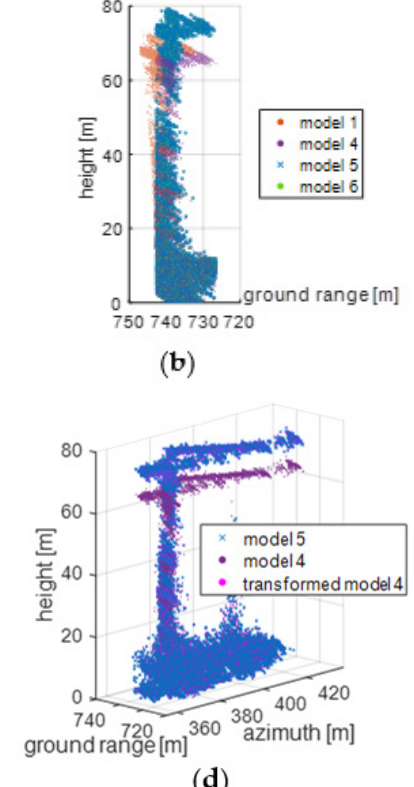
Table 8. The quantitative analysis of inversion results using measured data.